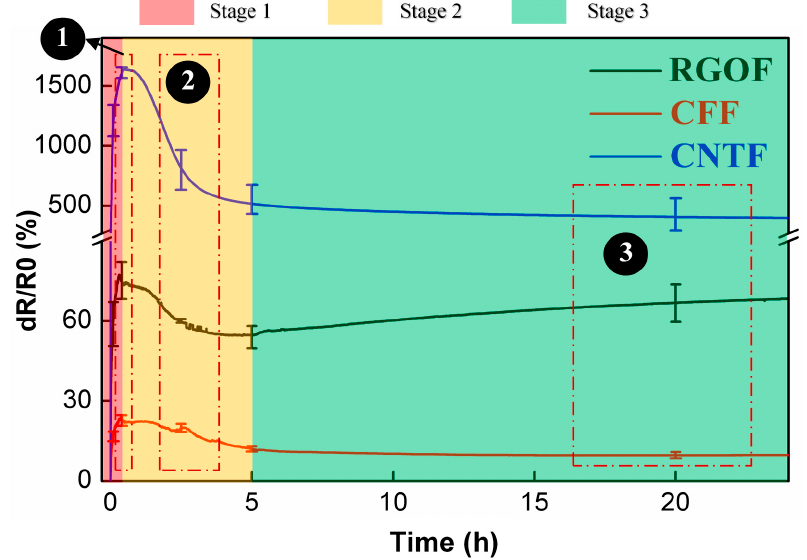
Figure 4. Comparison of the sensing performance of the CNTF, reduced graphene oxide-enabled fabrics (RGOF), and carbon fiber-enabled fabrics (CFF) for the in-line monitoring of FRP manufacturing.